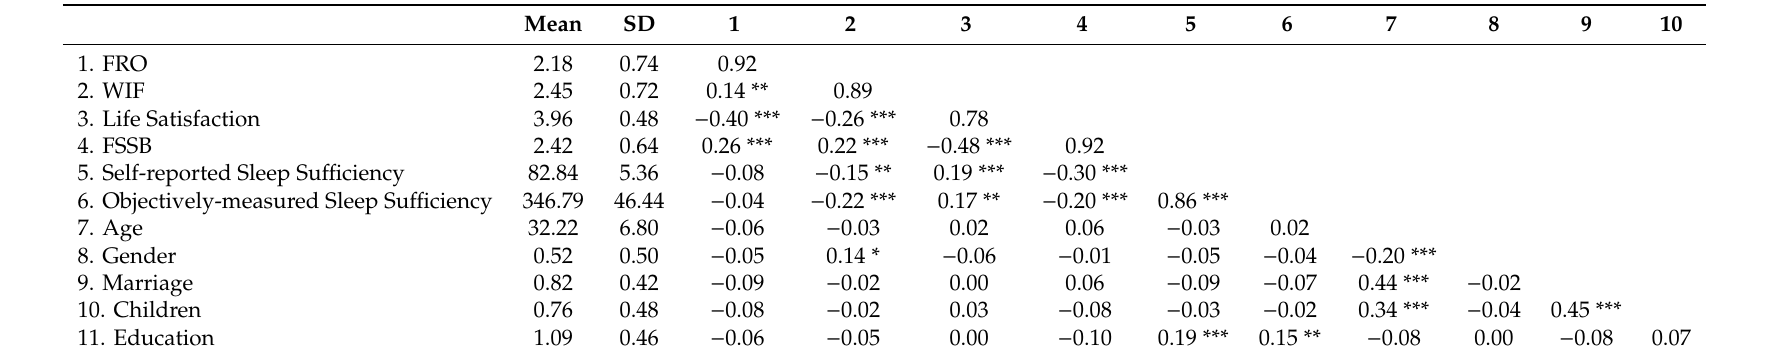
Table 1. Descriptive statistics and correlation